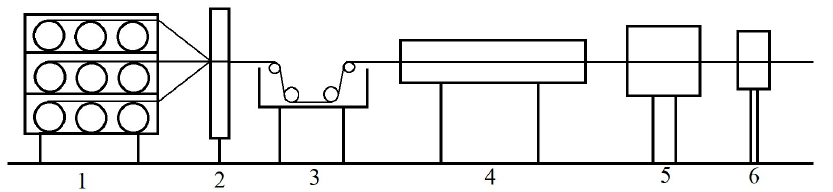
Figure 2. Schematic of pultrusion moulding (1. creel; 2. fibre guide; 3. resin impregnator; 4. mould; 5. tractor; and 6. cutter).